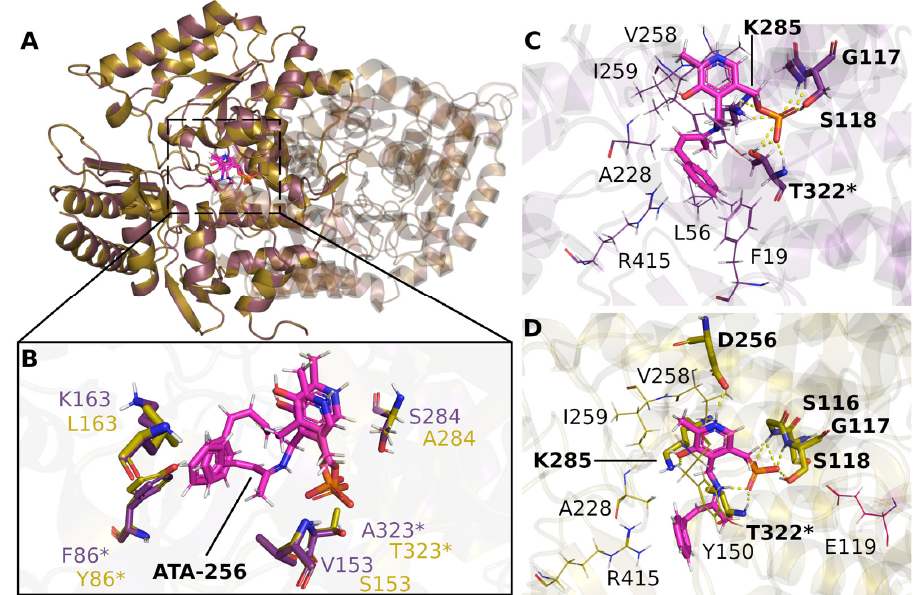
Figure 1. Comparison of the poses obtained by the molecular docking of 2a in the transaminase from V. fluvialis (purple) and ATA-256 (yellow). ( A ) Unconserved amino acids within a 5 Å radius of compound 2a are highlighted ( B ). Binding poses of 2a with V. fluvialis ( C ) and ATA-256 ( D ) transaminases, as suggested by docking studies. Hydrogen bonds are shown by yellow dashed lines and amino acids marked with * show that they belong to the B chain.